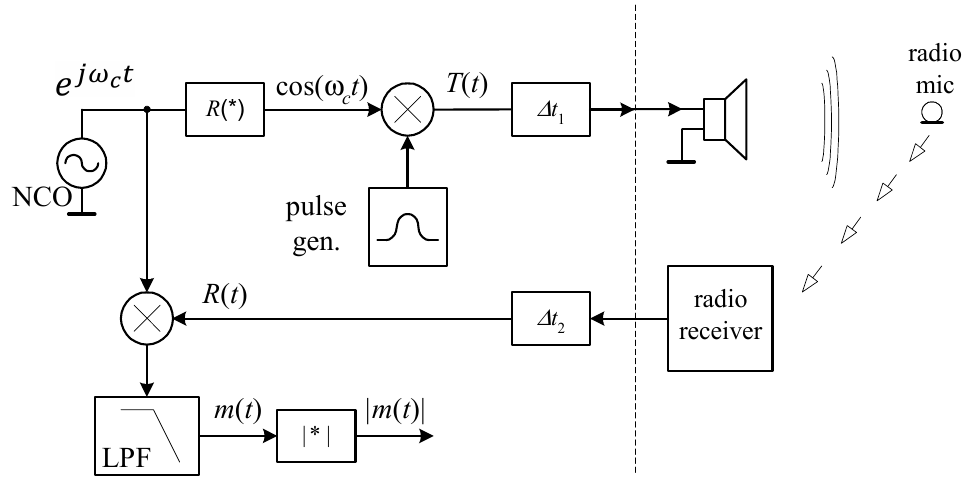
Figure 3. Schematic representation of the signal processing chain implemented in software. The vertical dashed line represents the interface between the digital-signal-processing (DSP) domain and the physical world. This transition is actually performed by the audio board.